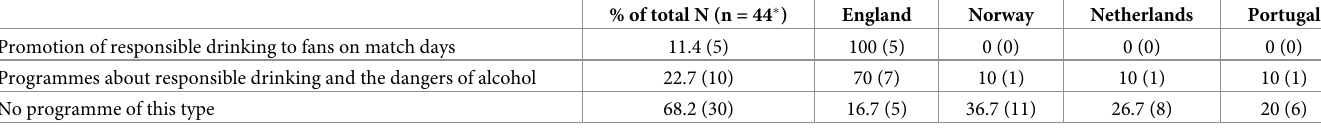
Table 5. Frequency of alcohol programmes delivered by professional football clubs in four European